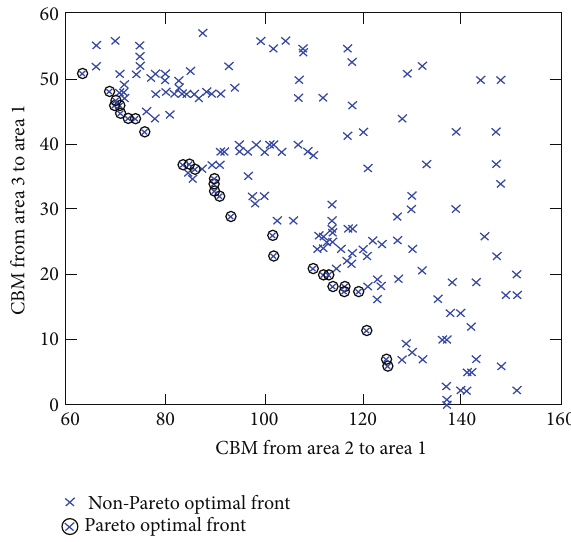
Figure 4: Pareto and non-Pareto optimal fronts of CBM for the two transfer cases.